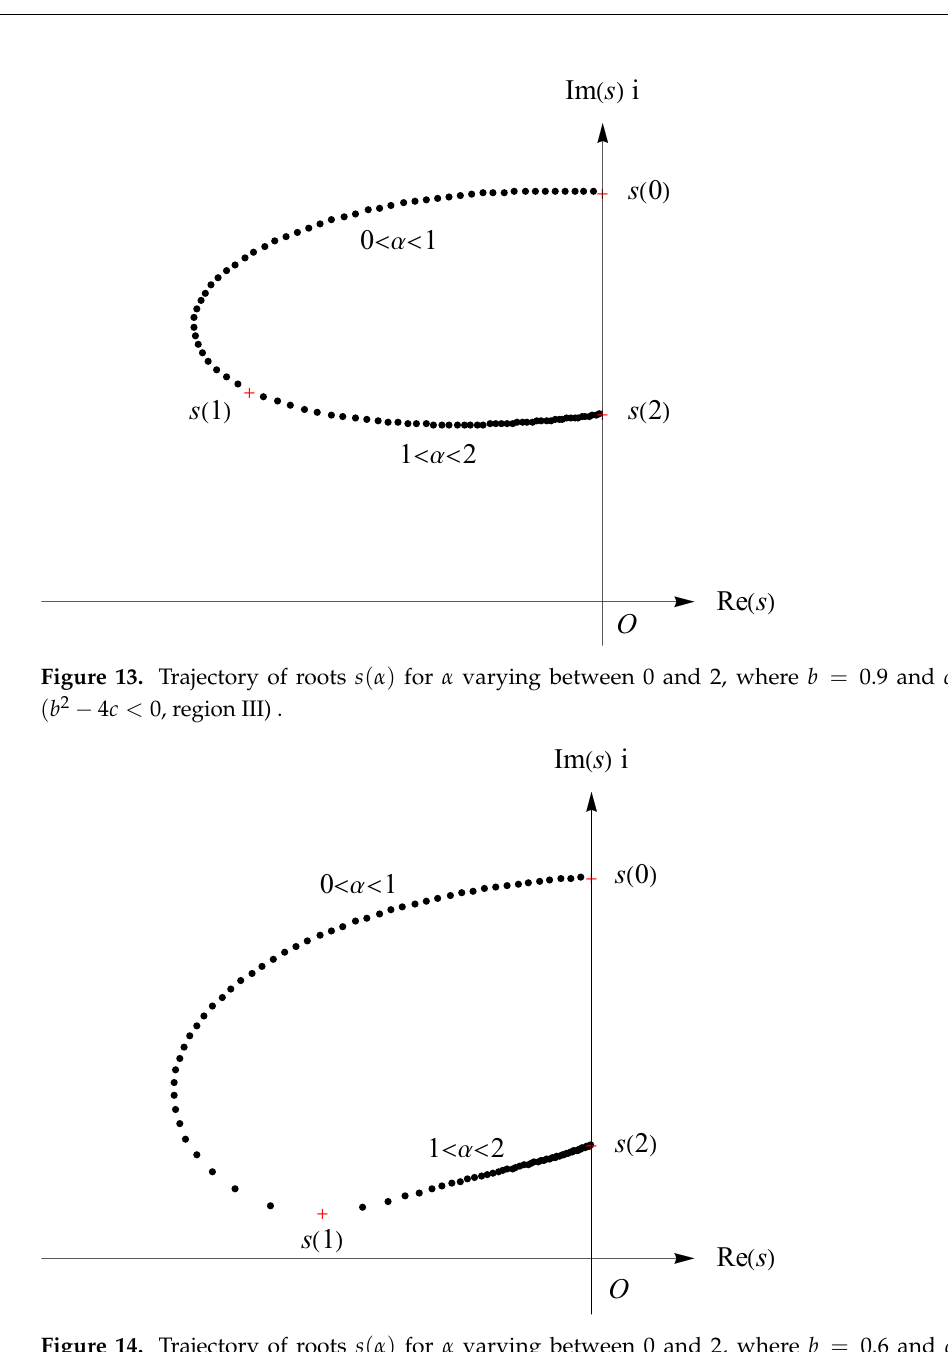
Figure 14. Trajectory of roots s ( α ) for α varying between 0 and 2, where b = 0.6 and c = 0.1 ( b 2 − 4 c < 0, region